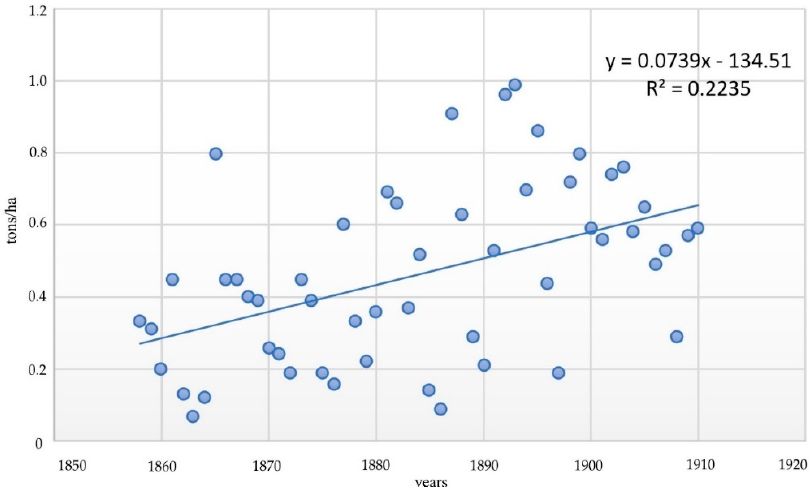
Figure 2. Winter wheat yields in 1850–1910, tons/ha. Source: authors’ development based on [112,114,116].